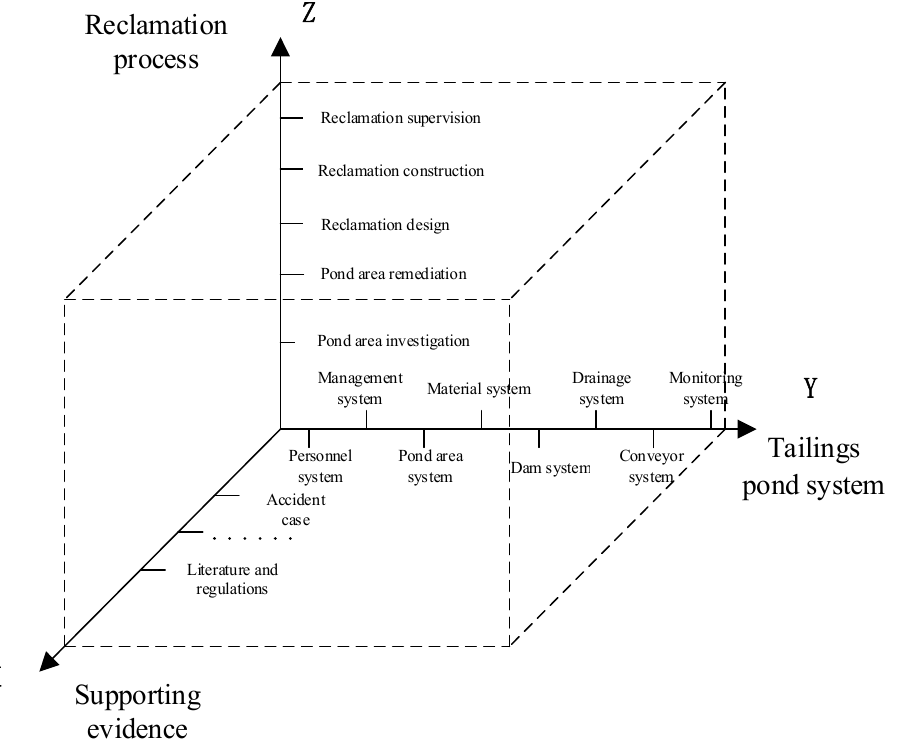
Figure 2. A three-dimensional identification framework for accident hazards based on